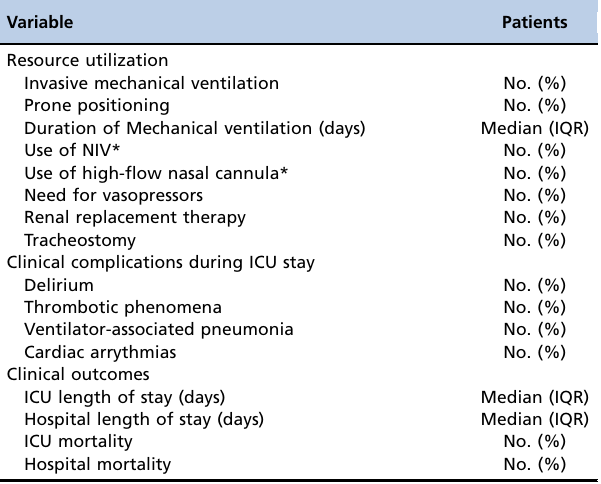
Table 4 - Clinical outcomes at ICU discharge.